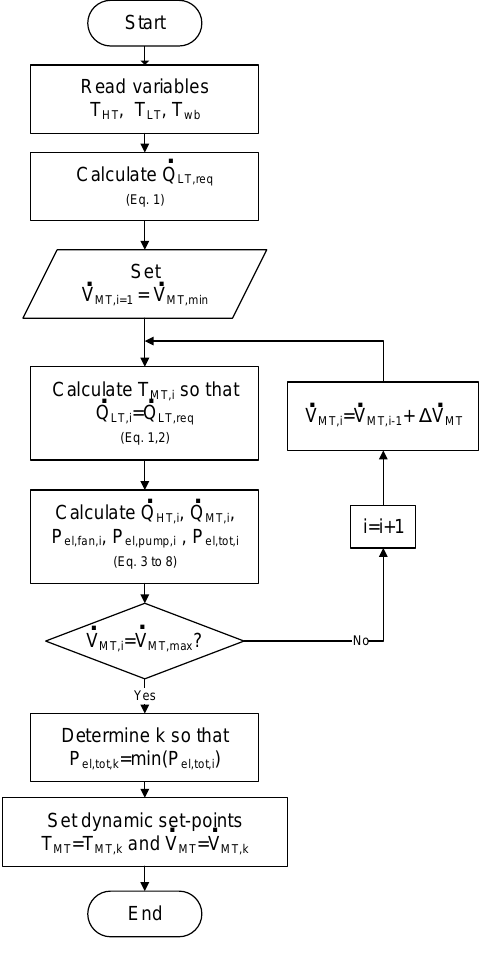
Figure A1. Flow chart of the optimization algorithm used for mode 3. In this work, the variation range of the cooling water flow rate has been segmented in 45 elements ( ˙ V MT ,min = 1.8 m 3 ˙ V 3 h − 1 and ∆ ˙ V MT = 0.04 m 3 MT ,max = 3.6 m ·